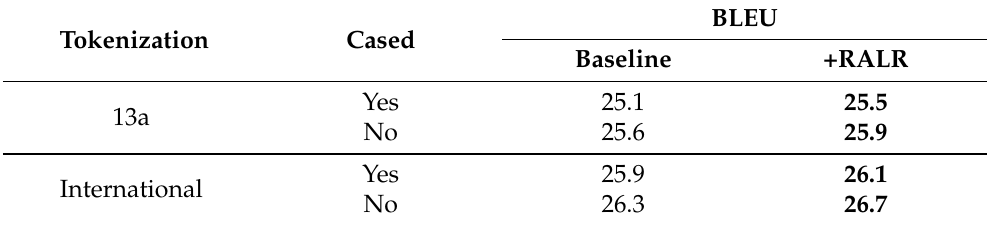
Table 5. Comparison results of WMT 2014.